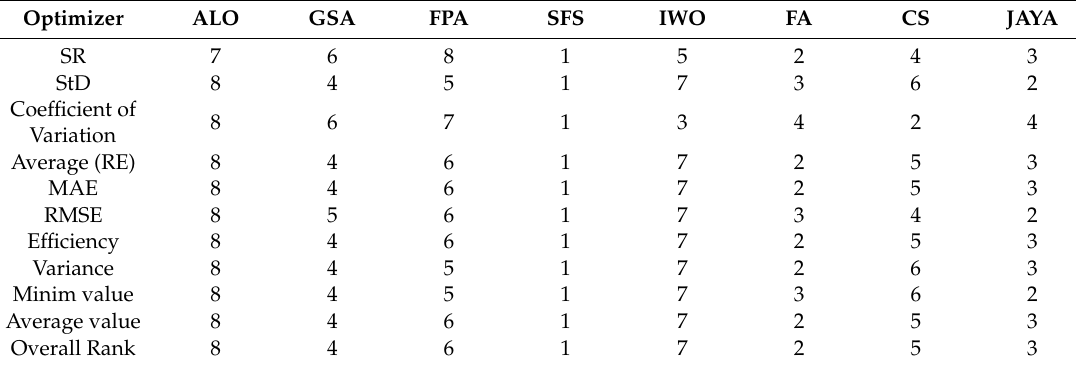
Figure 8. Performance comparison of different considered optimizers ( a ) success rate (SR); ( b ) standard deviation (StD); ( c ) coefficient of variation; ( d ) Average (RE); ( e ) RMSE and ( f ) Efficiency. Table 5. Ranking of considered global MPPT